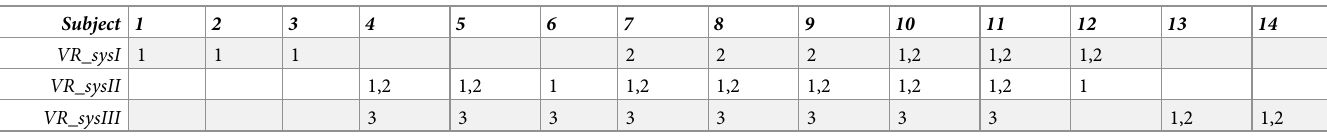
Table 2. IPQ data available for each participant.